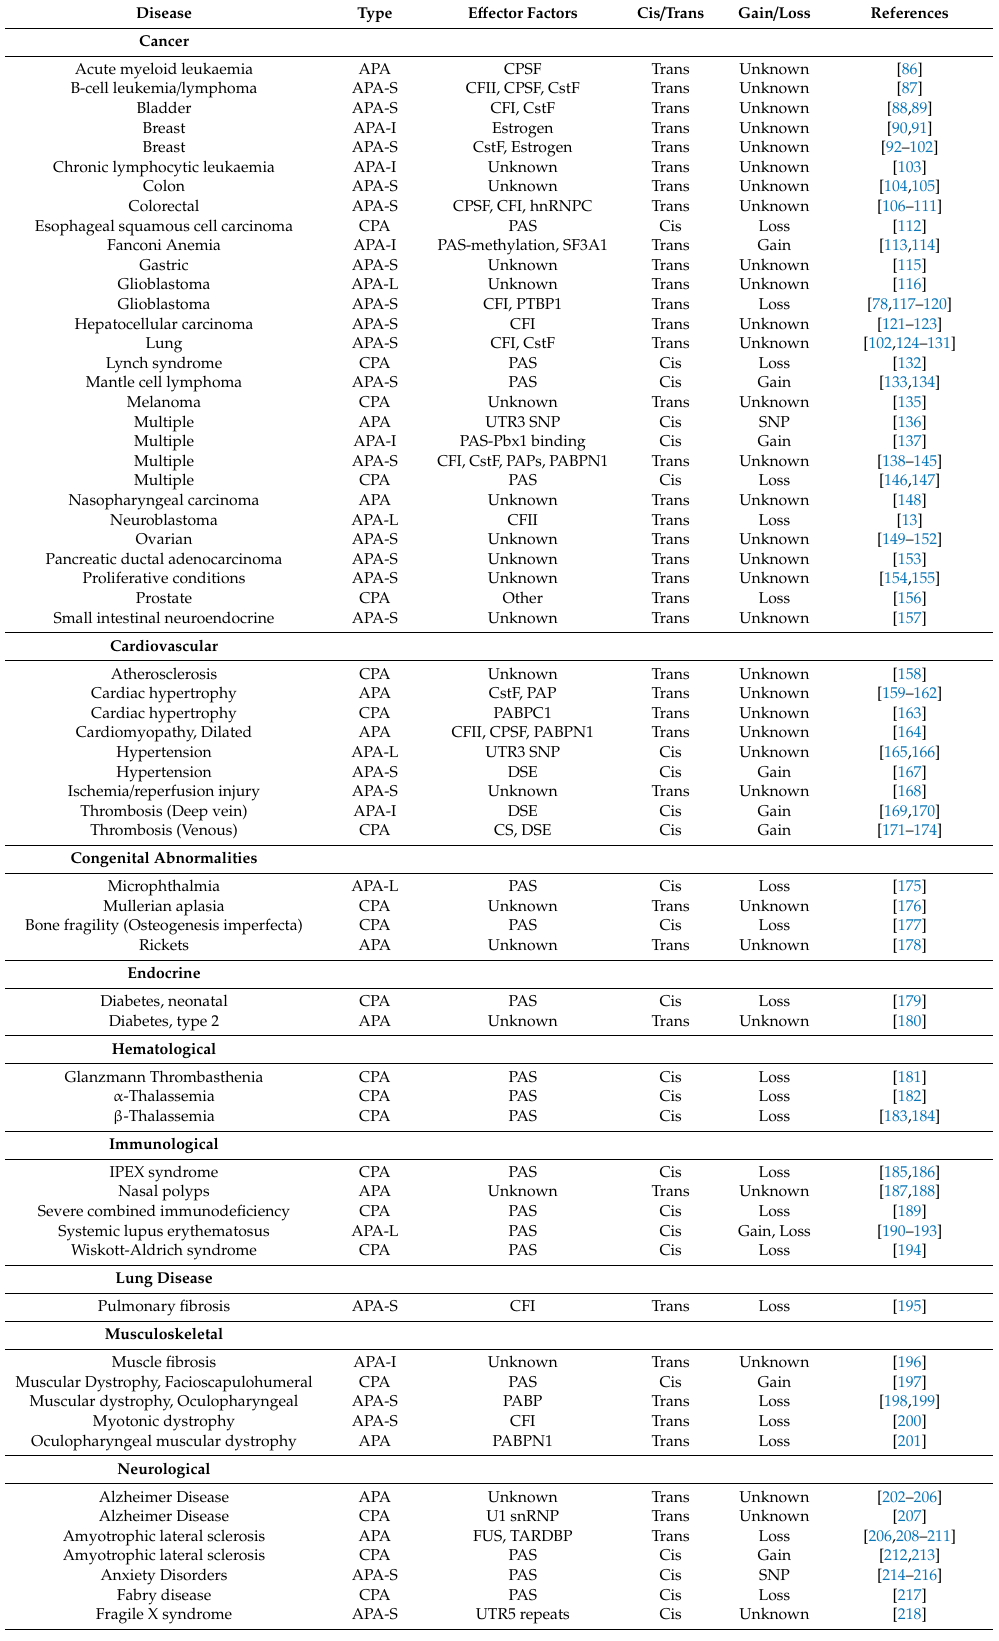
Table 1. CPA / APA and human